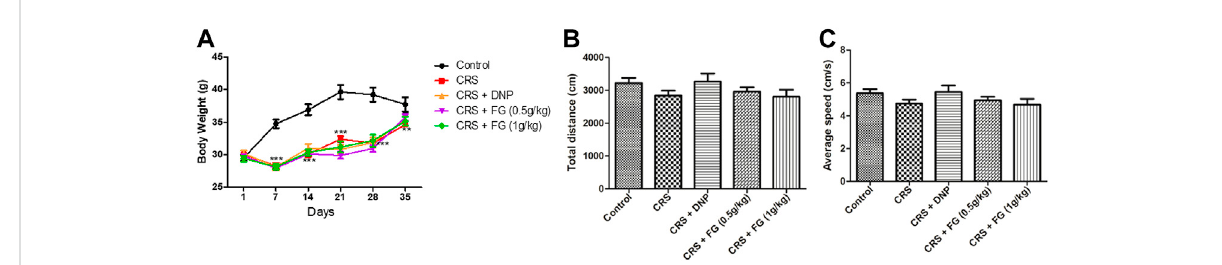
FIGURE 3 Effects of CRS, FG, and DNP on the locomotor activity of CRS mice in the open- fi eld test and body weight. (A) Body weight; (B) total motion distance; and (C) average speed. Values represent the mean ± S.E.M. n = 10 ~ 12